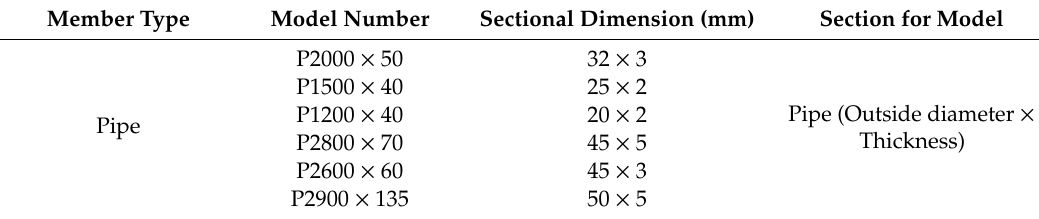
Table 3. Geometric dimension parameters of the jacket structure